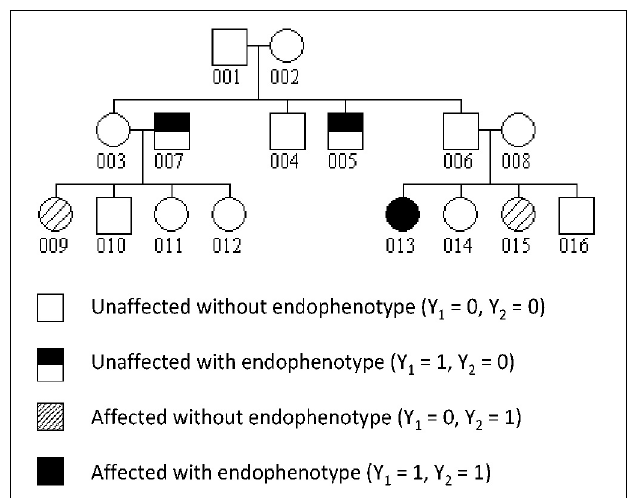
FIGURE 1 | Structure of simulated families with an example of phenotype